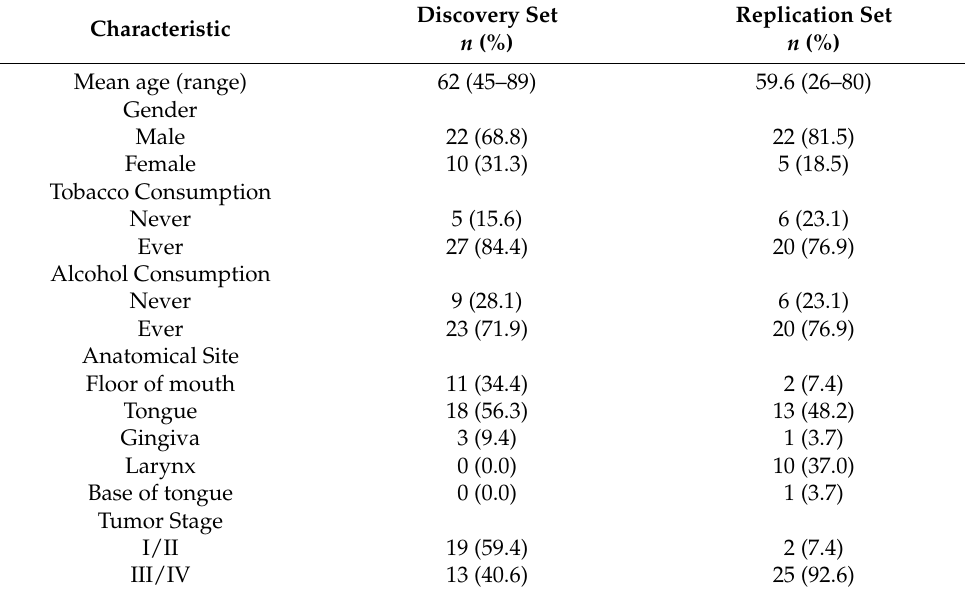
Table 1. Clinicopathological characteristics of the